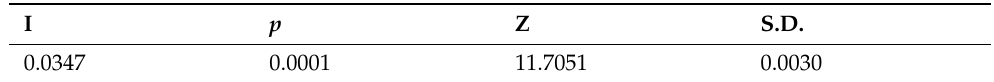
Table 5. The global bivariate Moran’s I index.